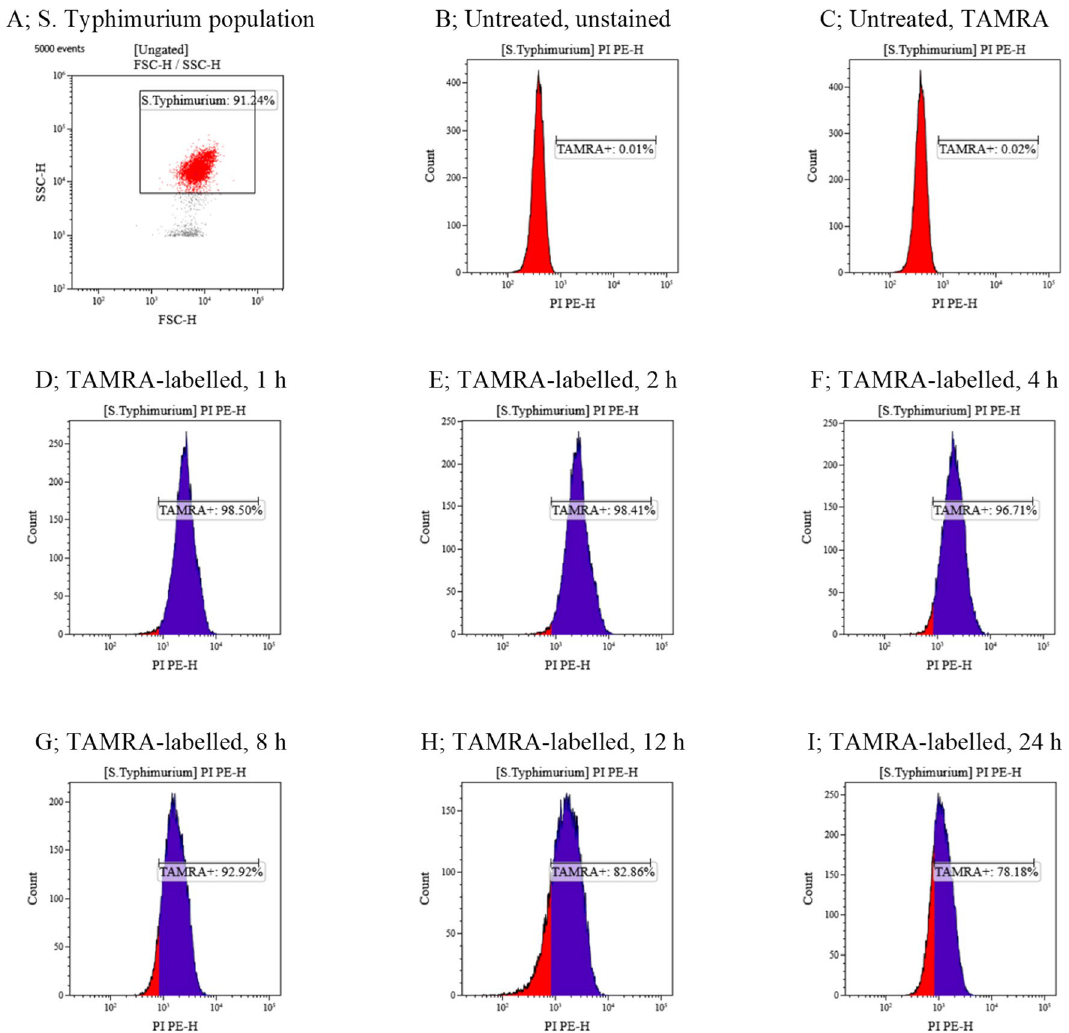
Figure 6. The membrane-penetrating activity of TAMRA-labelled A11 at 1 × MIC to S . Typhimurium ATCC 13311 as measured by flow cytometry. S . Typhimurium cell population ( A ), and untreated S . Typhimurium without staining ( B ). Untreated S . Typhimurium stained with TAMRA ( C ), and membrane-penetrating effect of TAMRA-labelled A11 after 1, 2, 4, 8, 12 and 24 h incubation ( D – I